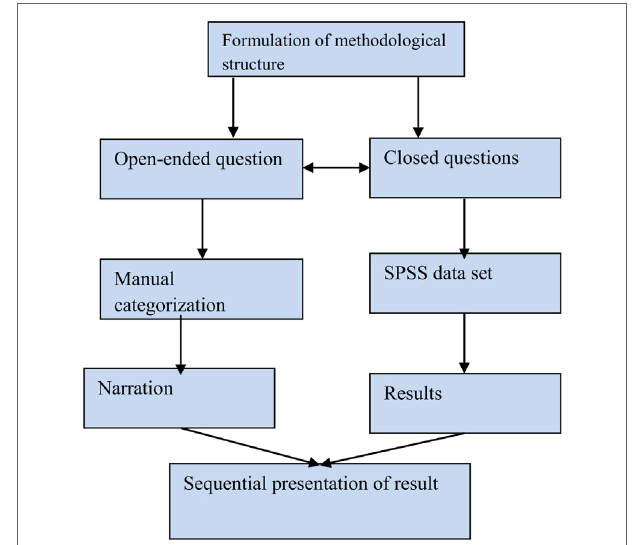
FigUre 1 | Concurrent mix study design: Driscoll